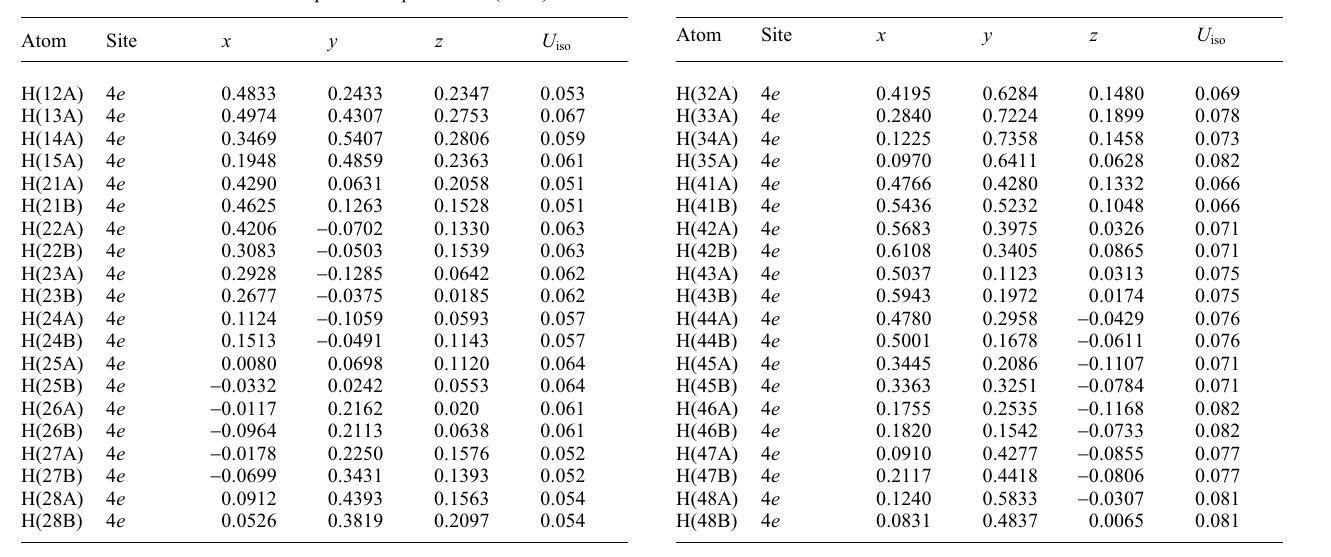
Table 2. Atomic coordinates and displacement parameters (in Å 2 )